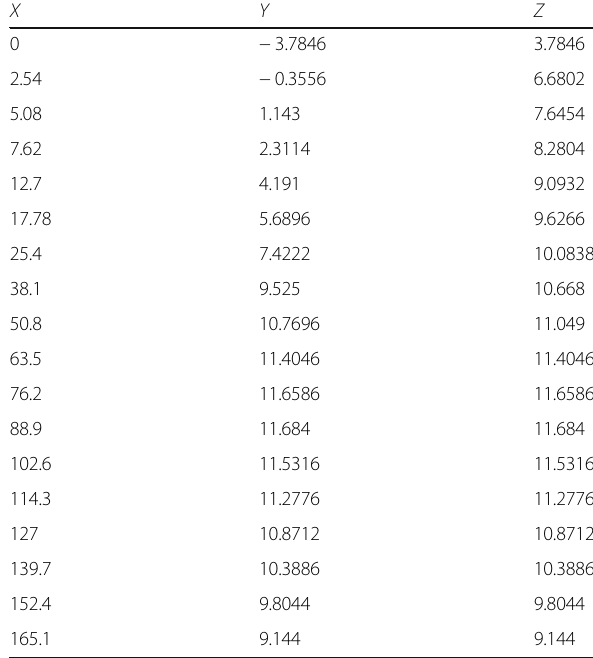
Table 1 Geometrical characteristics of the fin tail rotor Geometrical characteristics